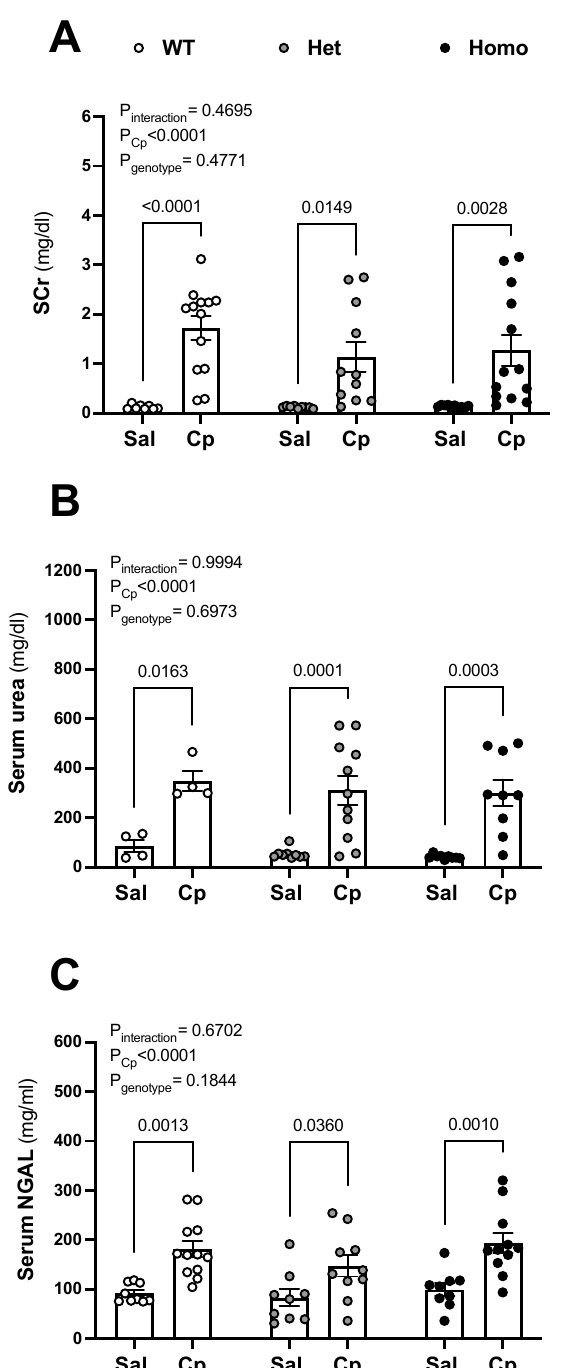
Figure 2. Cisplatin-induced rise in serum levels of kidney injury markers. Serum levels of creatinine (SCr, ( A )), urea ( B ), and neutrophil gelatinase-associated lipocalin (NGAL, ( C )) on day 3 after cisplatin (Cp, 20 mg/kg) or saline injections were measured in male, mice homozygous (homo) and heterozygous (het) knockout for GPER1 gene, and wild-type (WT) littermates. Data are presented as mean ± SEM (n = 4–13 mice/group). Statistical comparisons were performed by two-way ANOVA with Sidak’s post hoc test for multiple comparisons ( A – C ). p values for ANOVA and post hoc test results are displayed on the figures. Cp, cisplatin; Het: heterozygous knockout for GPER1 gene; Homo, homozygous knockout for GPER1 gene; Sal, saline; SCr, serum creatinine; WT,